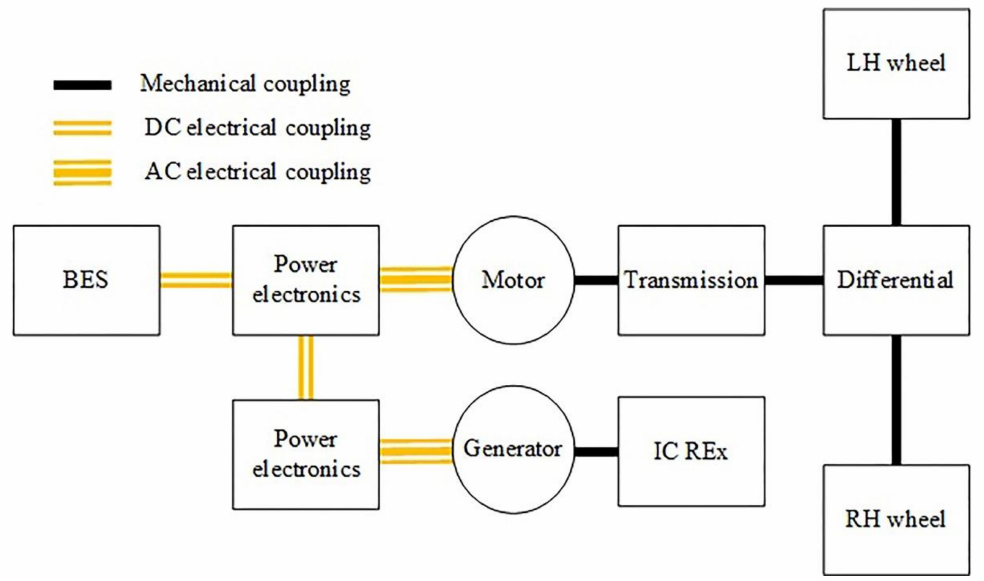
Figure 1. The basic architecture of REEV with an electric motor, generator, IC engine REx, BES, and power